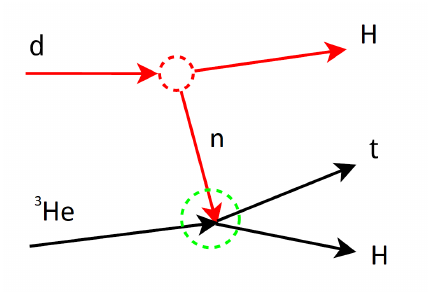
Figure 1. Sketch of the process: deuteron breaks up into a neutron (participant) and a proton (spectator) in a quasi-free process.